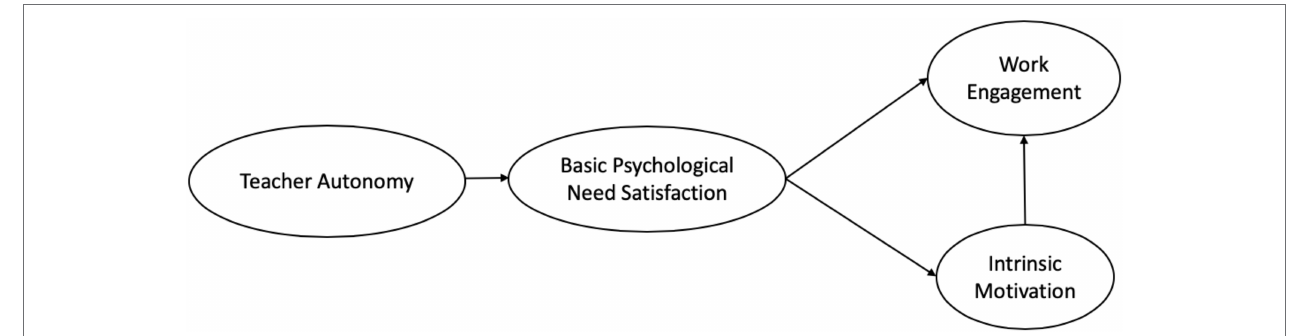
FIGURE 1 | Self-determination theory model showing hypothesized relationships between teacher autonomy, satisfaction of basic needs (autonomy, competence, and relatedness), intrinsic motivation, and